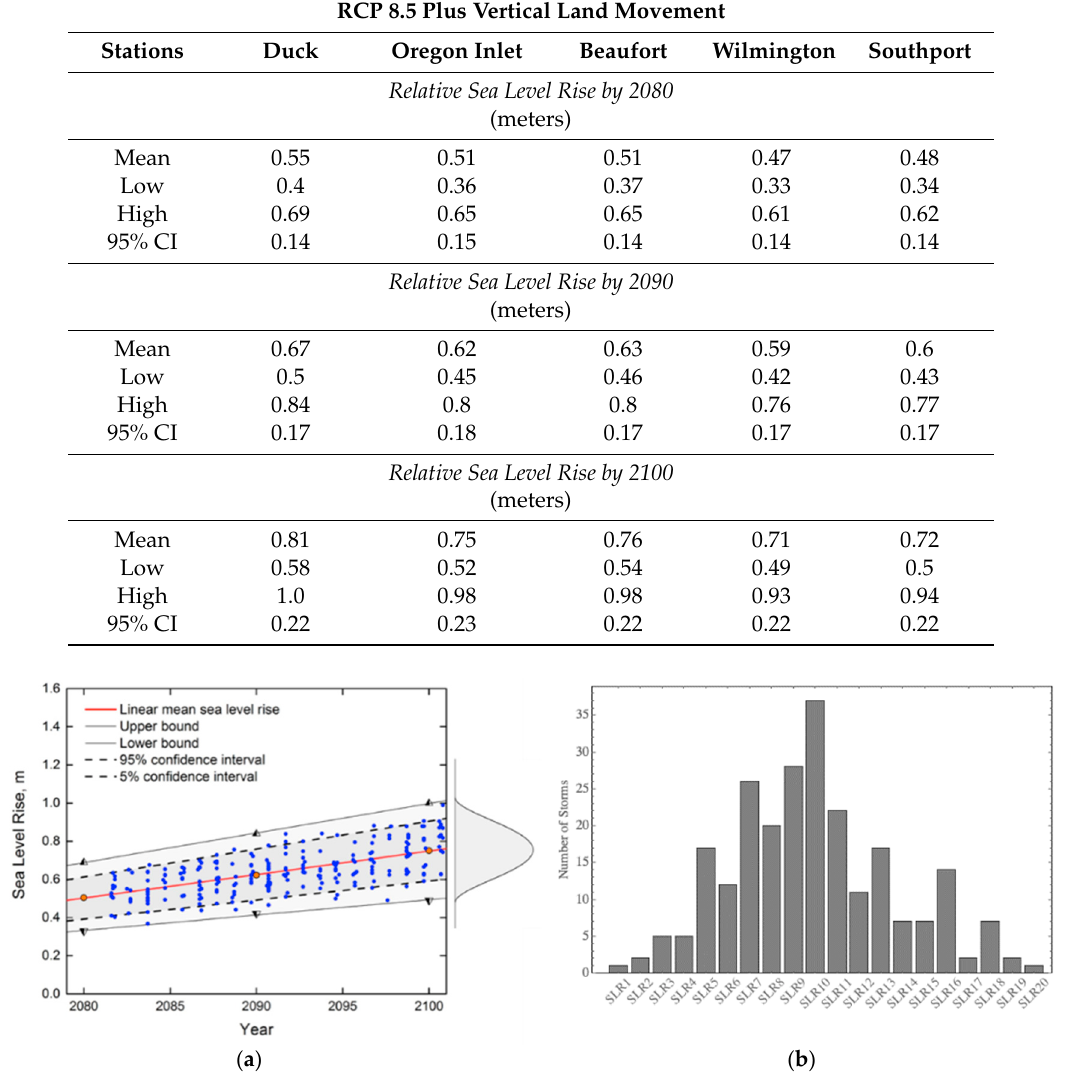
Table 2. Relative sea level rise for three time periods considering potential rates of sea level rise from the RCP 8.5 study (RCP 8.5 which is the highest greenhouse gas emission scenario, combined with estimated vertical land movement at the tidal gauges).